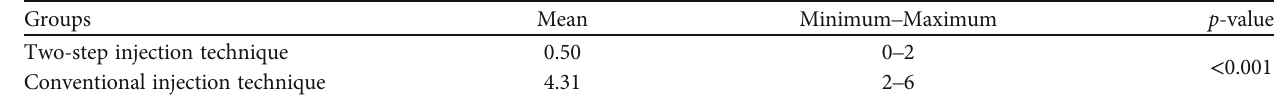
T ABLE 3: Comparison of pain score in two